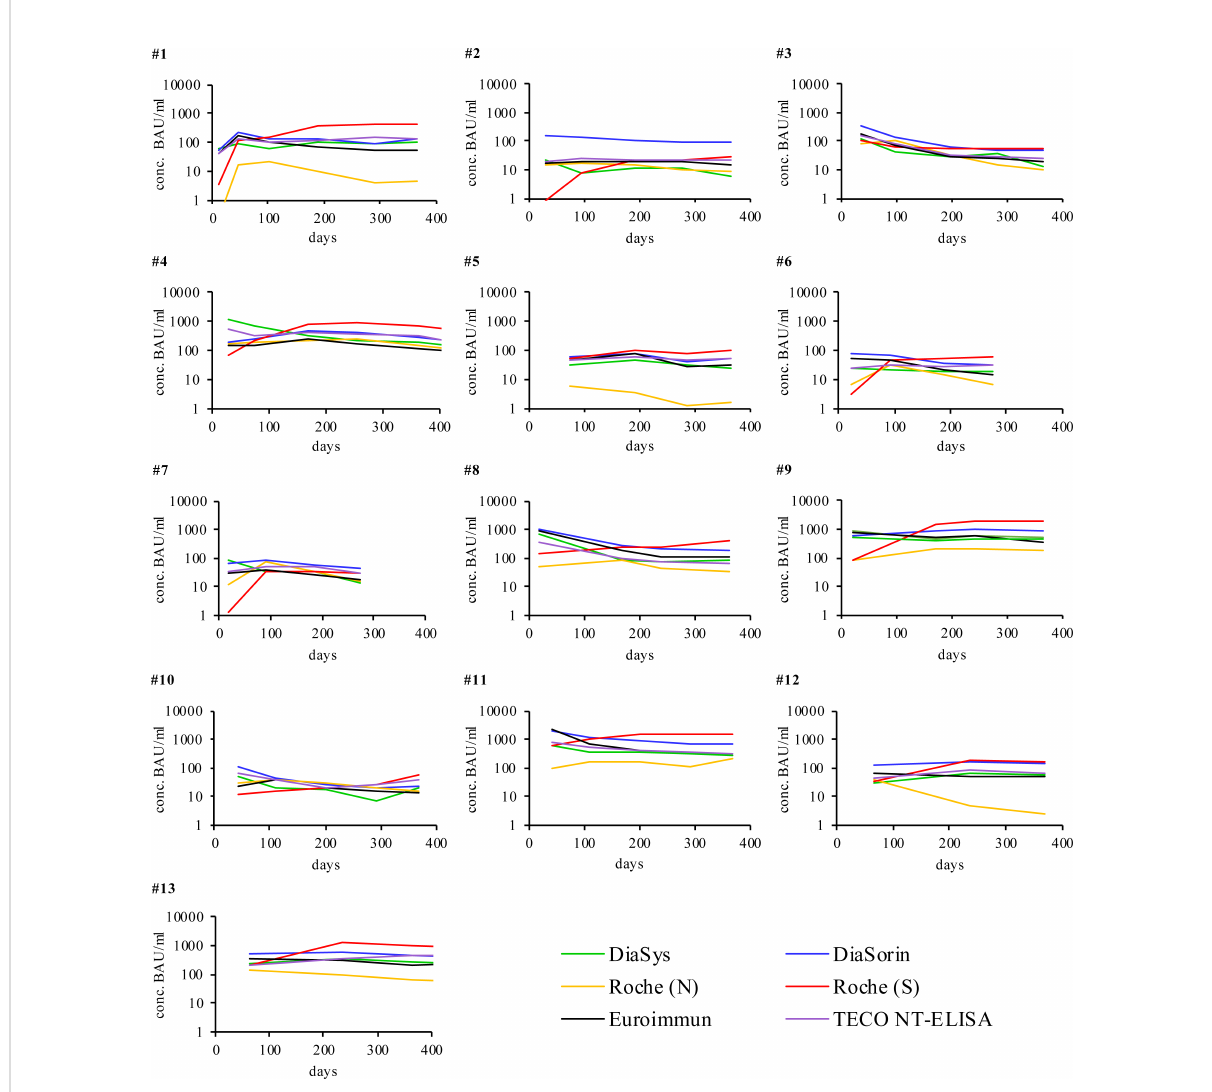
FIGURE 1 Individual humoral antibody immune response of participants recovered from COVID-19 monitored over respective days with different immuno-assays. Signals were measured in BAU/ml (y-axis) except for Roche (N) in cut-off-index (COI). The respective cut off values of the different assays are reported in Table 1. X-axis represents duration of evaluation in days. Participants 6 and 7 stopped after 270 days due to the fi rst vaccination. For a more detailed analysis of the participants please also refer to Supplement Table